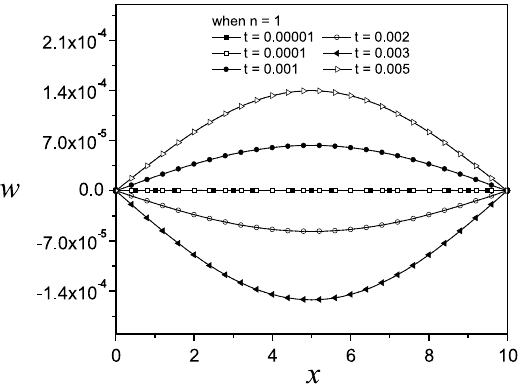
Fig. 18. Deflection of the mid-plane for the simply supported FGPM cylindrical shell imposed by a sinusoidal distributed load, when n = 1 .